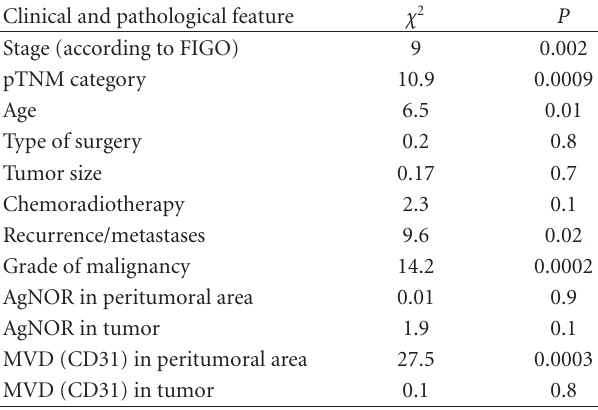
Table 3: Significance of prognostic criteria as evaluated by Cox re- gression multivariate analysis.